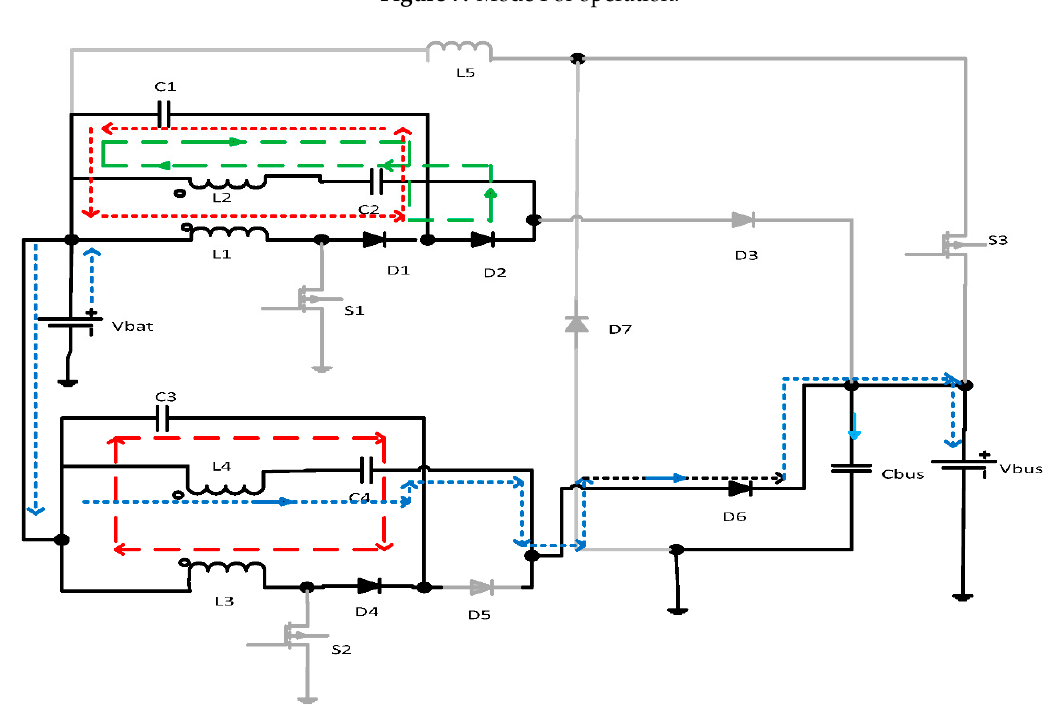
Figure 8. Mode II of operation.